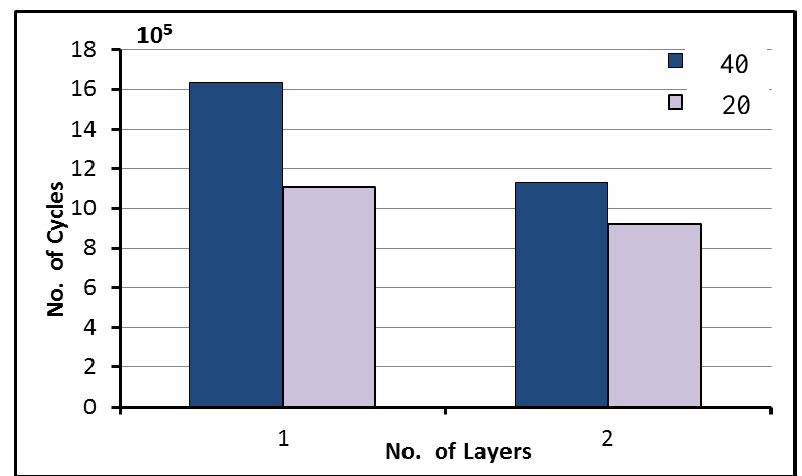
Fig.3: The relation between fatigue cycle and number of layer for uniform glass fiber at volume fractions 20% and 40%.